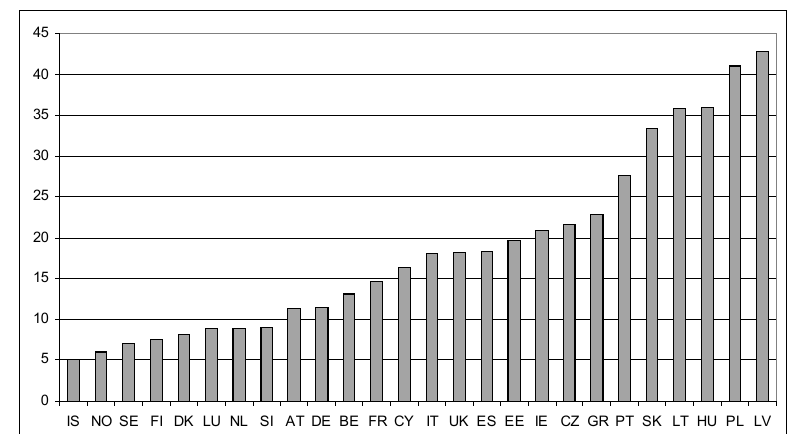
Figure 10 : Proportion of children living in families with two of a relatively low income, deprived or under economic strain